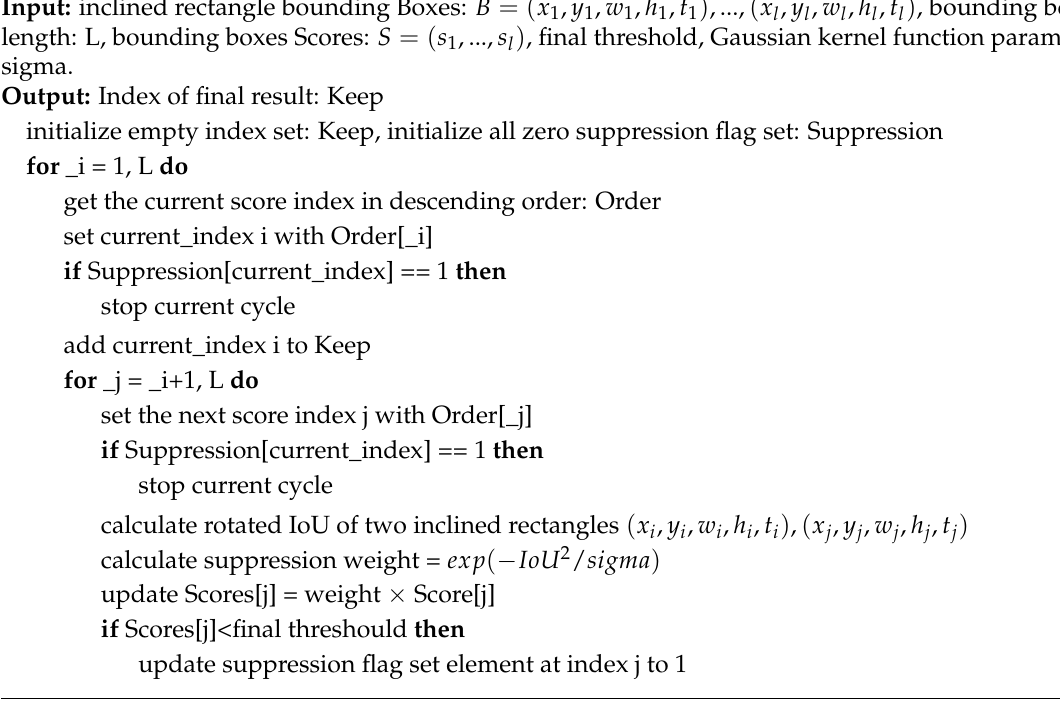
Algorithm 2 Soft Rotation Non-Maximum